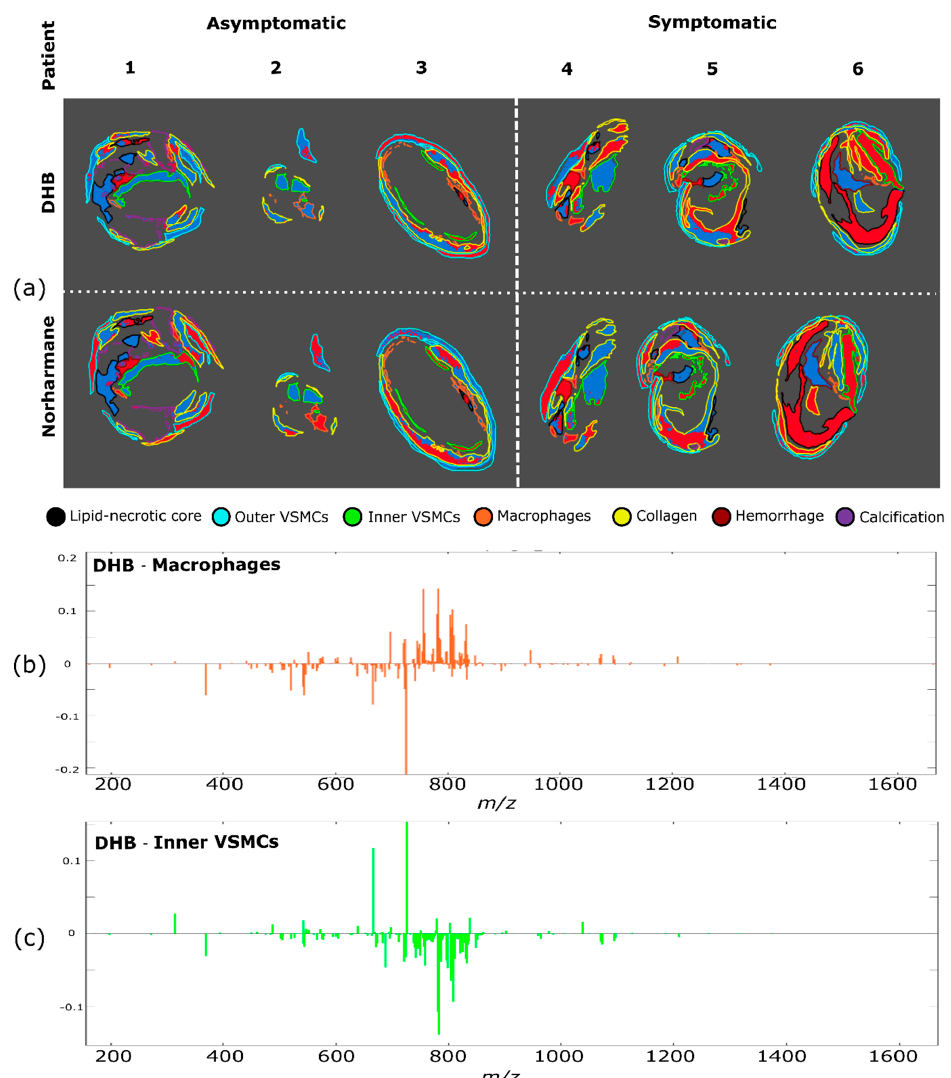
Figure 4. Cluster analysis for each region. ( a ) Pixels of each region were subjected to k-means clustering (two clusters for each region, red and blue) to discriminate between asymptomatic and symptomatic plaques. Region identity is coded by the border color. Clustering of different regions was performed independently. Difference between spectra of the blue and the red clusters (corresponding to cluster 1 and cluster 2) for ( b ) macrophages and ( c ) inner VSMCs regions of the DHB dataset.